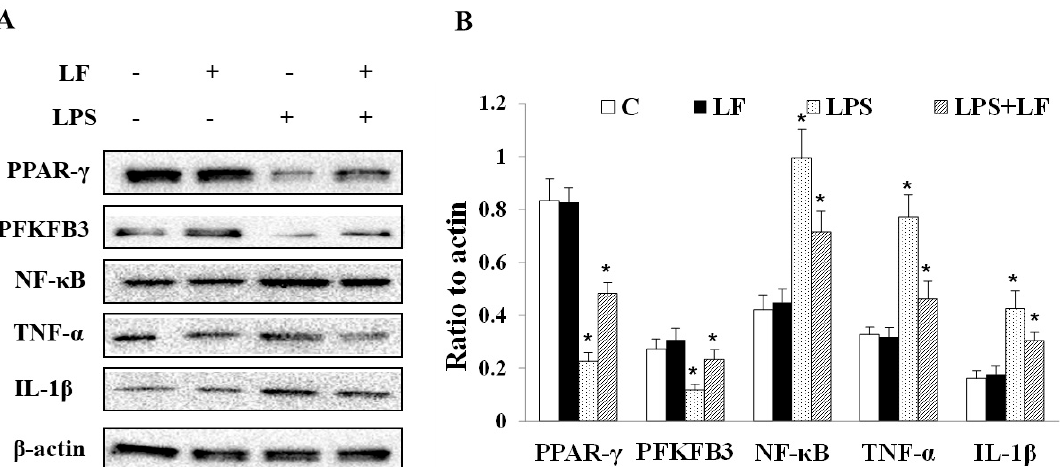
Figure 5. Effects of apo-LF and LPS alone or in combination on inflammation related proteins in colonic tissue of young mice. ( A ) Protein extracts were immunoblotted to capture protein bands. ( B ) Quantification analysis of protein band density. C represents control. LF represents apo-LF. Apo-LF represents individual treatment with 100 mg/kg b.w. apo-LF, LPS represents individual treatment with 10 mg/kg b.w. LPS, LPS + apo-LF represents combined treatment with of 10 mg/kg b.w. LPS and 100 mg/kg b.w. apo-LF. Data analyzed were presented as means ± SD. * means comparison with the control group, * p < 0.05.